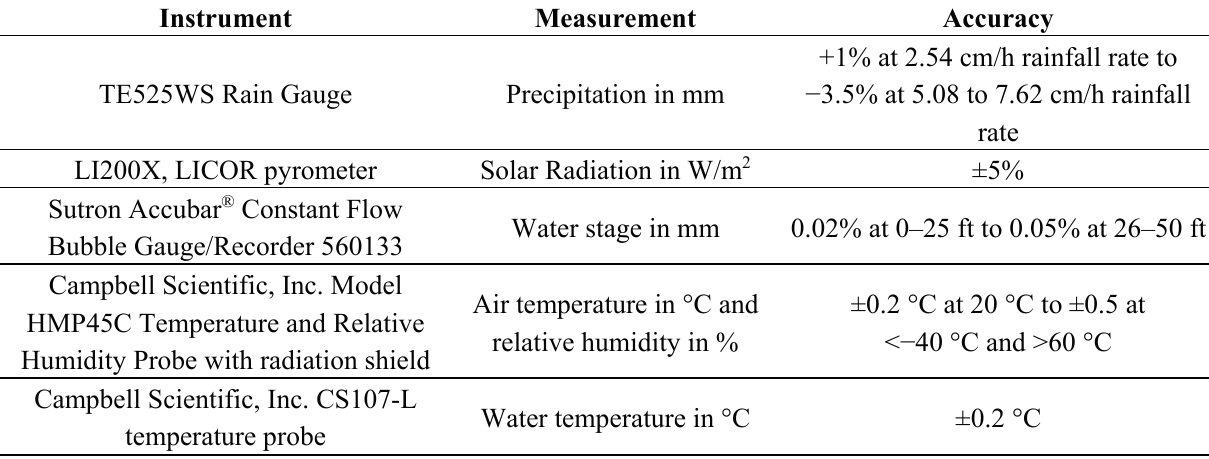
Table 2. Instrumentation installed at gauging sites along Hinkson Creek, Missouri, USA, and associated variables sensed, necessary for the current